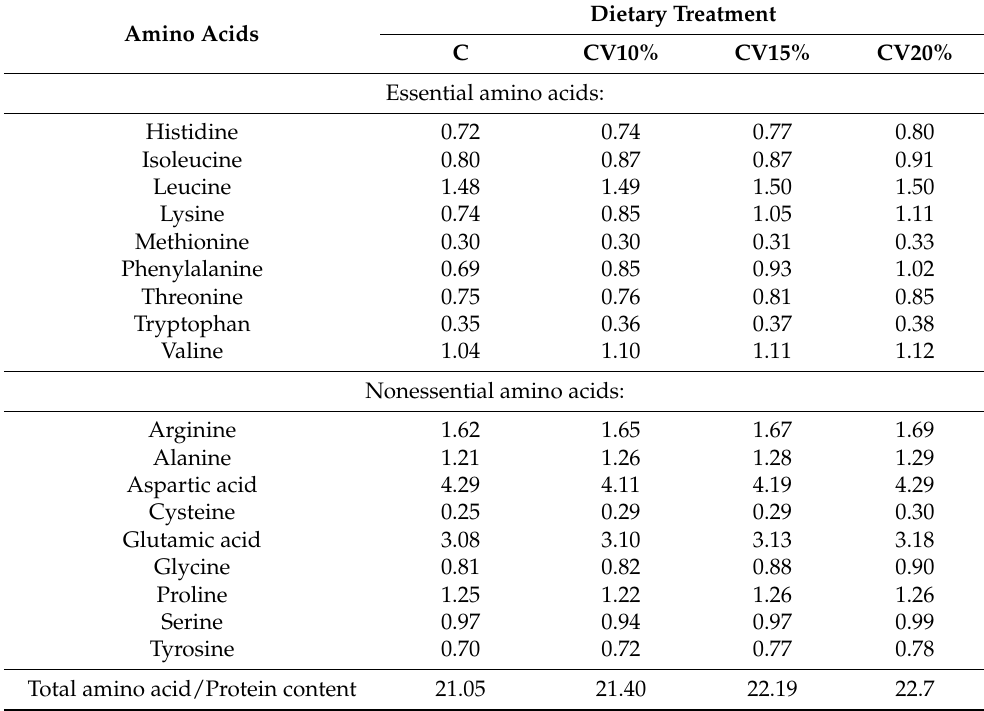
Table 3. Amino acids profiles of experimental diets (g/100